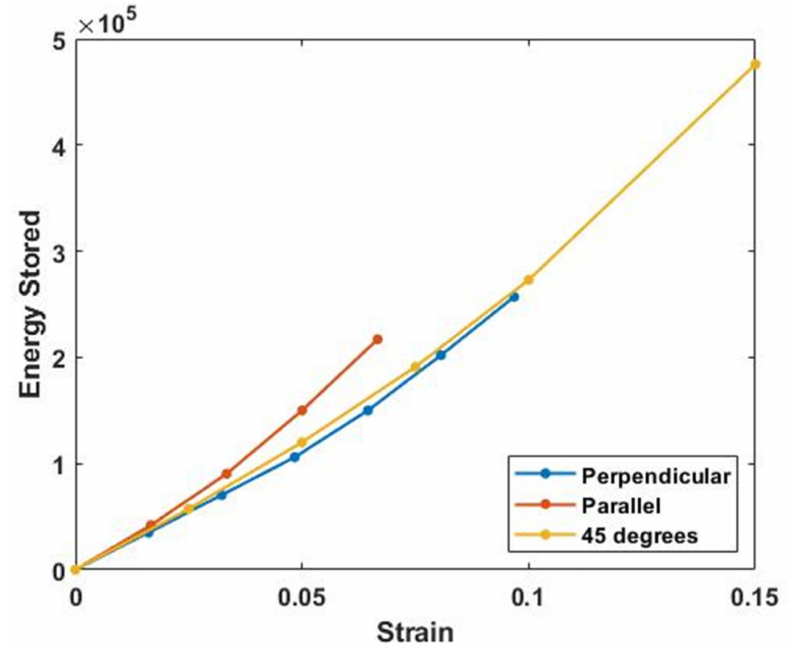
Figure 6. Energy stored parallel (0 ◦ ), at 45 ◦ , and perpendicular (90 ◦ ) to the collagen fiber orientation in vivo calculated from the area under the modulus-strain curves (with units of MPa). The external strain was applied by stretching the skin with a piece of tape. Note the energy stored in skin appears almost independent of the angle of orientation.